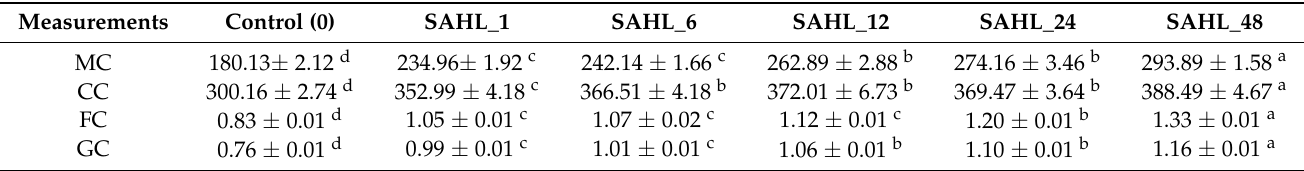
Table 1. Effects of SAHL treatments on the measurements of H. pluvialis .